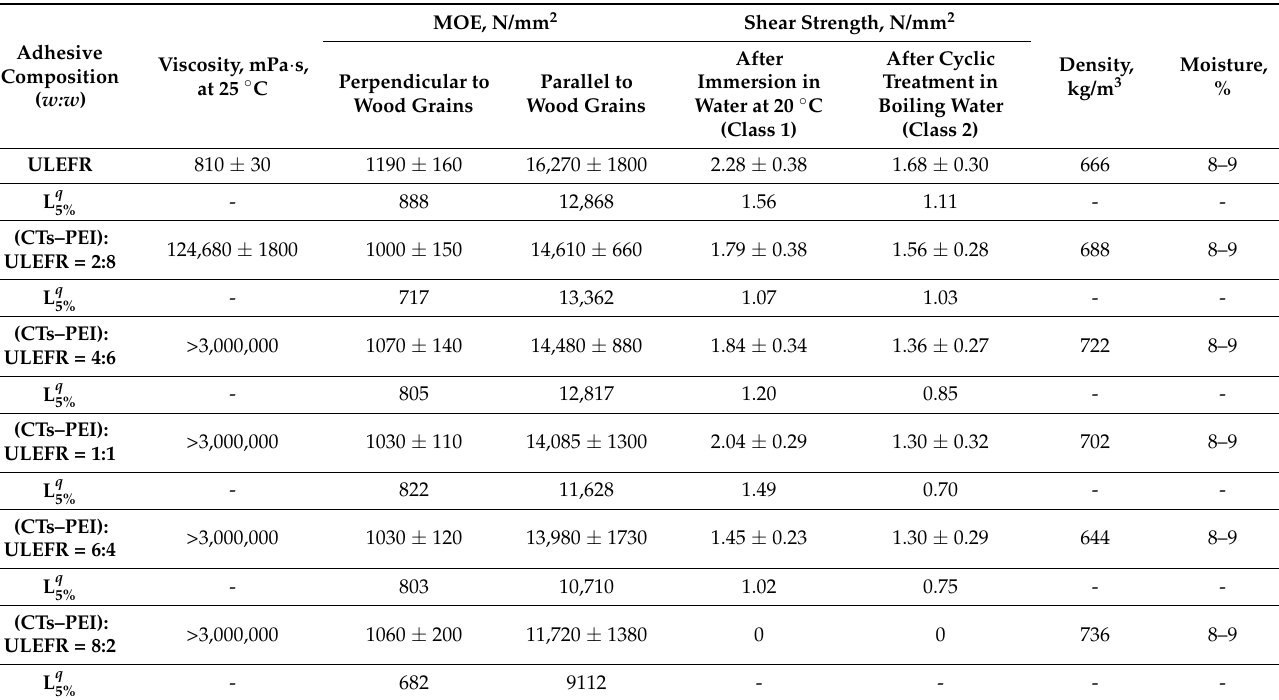
Figure 11. Differential thermogravimetric curve of the CTs–PEI-ULEFR and CTs–PEI adhesive systems. Table 4. Properties of used adhesive systems and obtained